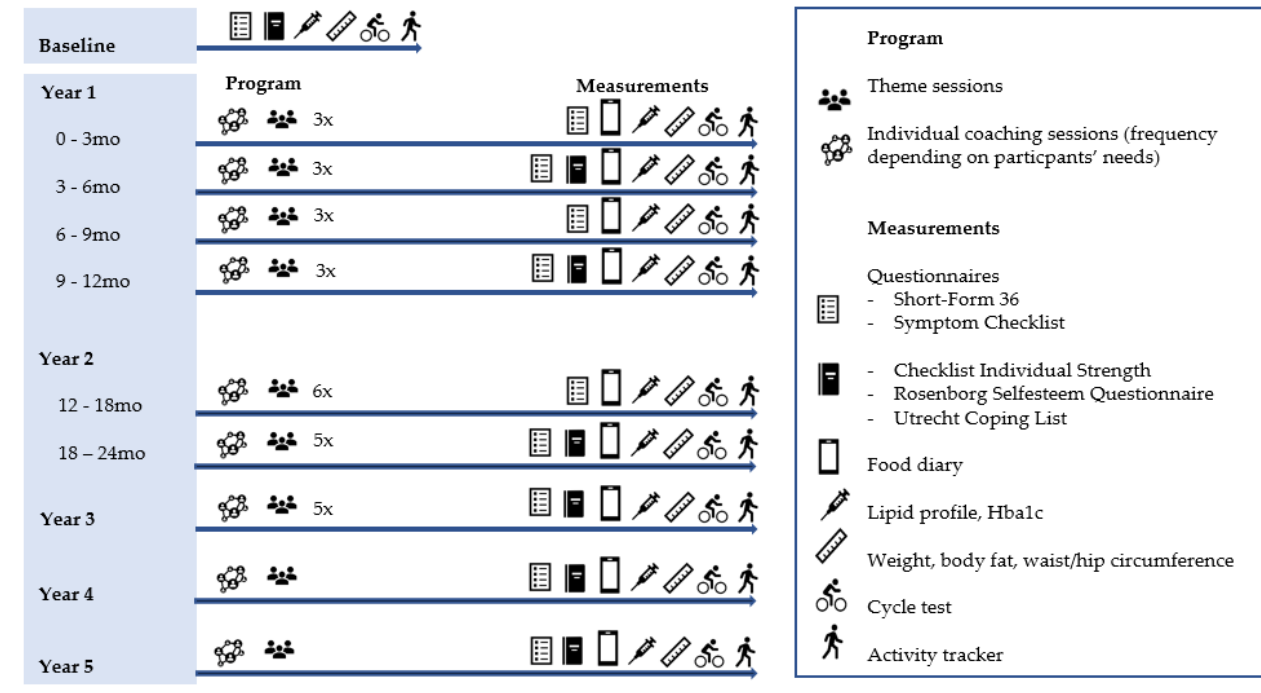
Figure 3. Description of the personalized integrative obesity-coaching program.